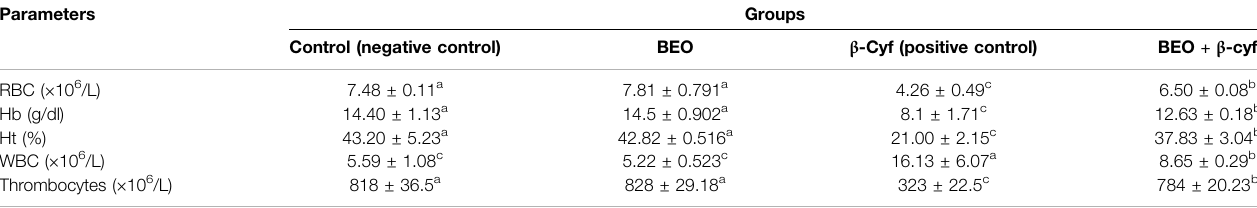
TABLE 5 | Hematological analysis in different groups.